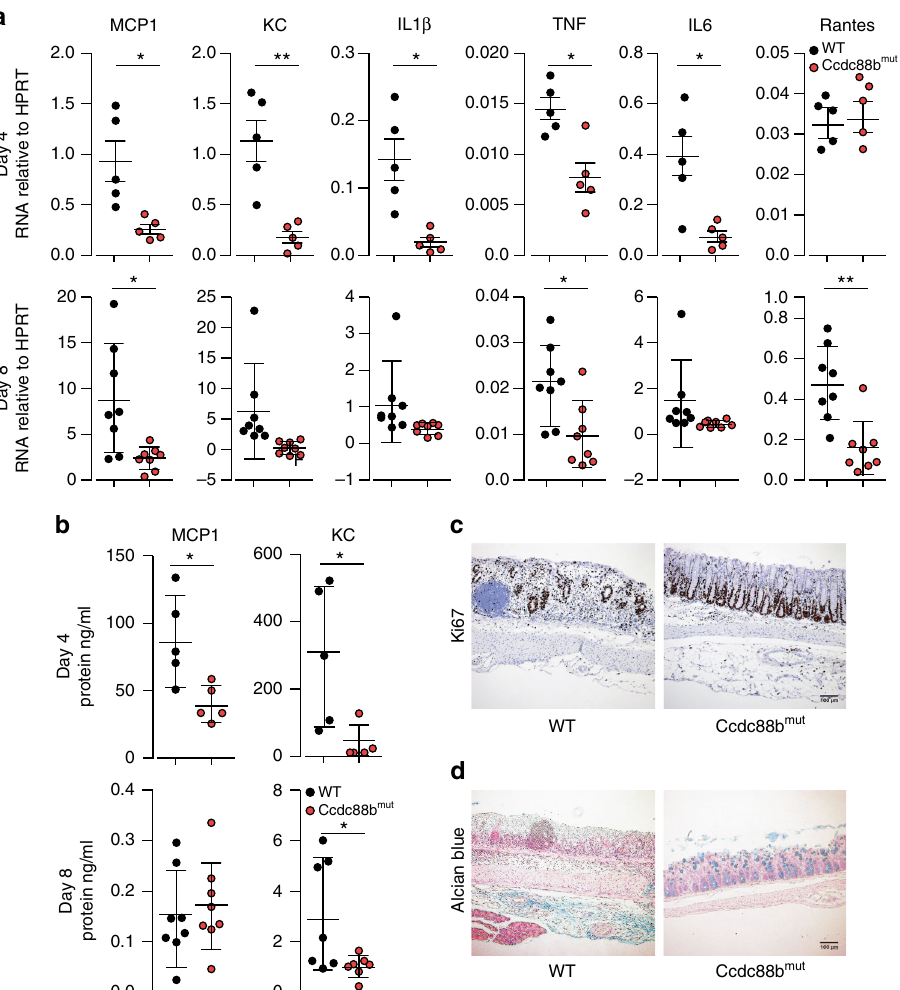
Fig. 3 Loss of Ccdc88b on in fl ammatory response to DSS-induced colitis. WT and Ccdc88b mut mice were treated with 3% DSS for 5 days followed by 3 days of water. a Relative expression levels of indicated cytokine and chemokine mRNAs extracted from WT and Ccdc88b mut colon mice at day 4 ( n = 5) and day 8 ( n = 10) following DSS treatment (mean ± SEM; * P < 0.05, ** P < 0.01; two-tailed Student ’ s t -test). b Proin fl ammatory cytokine MCP1 and KC were quanti fi ed in serum by ELISA, and results are presented in ng/ml (mean ± SEM; *** P < 0.001; two-tailed Student ’ s t -test). a , b Data are pooled from 2 independent experiments. c Representative image ( n = 4) of crypt regeneration visualized by Ki-67 staining (hematoxylin counterstaining), Scale bars, 100 µ m. d Representative image ( n = 4) of epithelial integrity by mucin staining (Alcian blue) of colons from DSS-treated mice at day 8. Scale bars, 100 µ